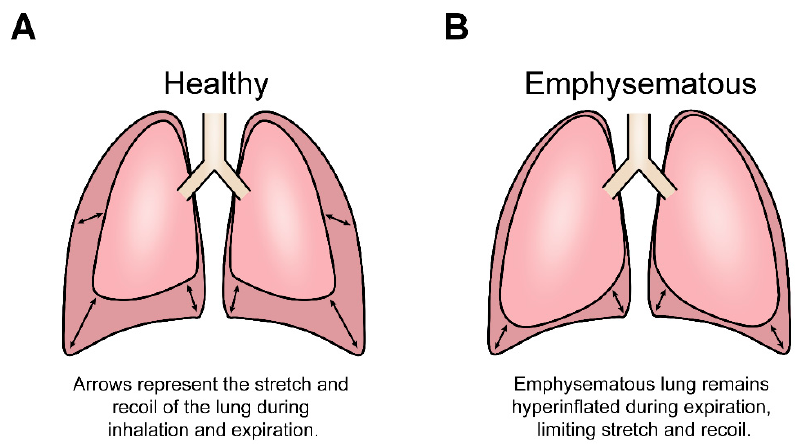
Figure 1. Variations in the mechanical stretch between healthy and emphysematous cells. ( A ) The difference in volume between inhalation and exhalation of a healthy lung. ( B ) The inhalation and exhalation of a lung with emphysematous hyperinflation, a symptom of emphysema. The emphysematous parenchyma loses elasticity, causing the lung to become incapable of fully recoiling between breaths, thus remaining hyperinflated. Lung cell populations experience reduced flux in the stretch during emphysema.